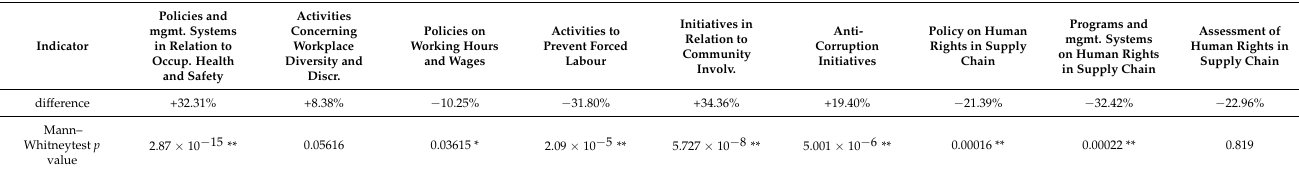
Table 6. Differences in mean values of grades obtained in social area by groups of mining, energy, and energy utilities compared to other companies under